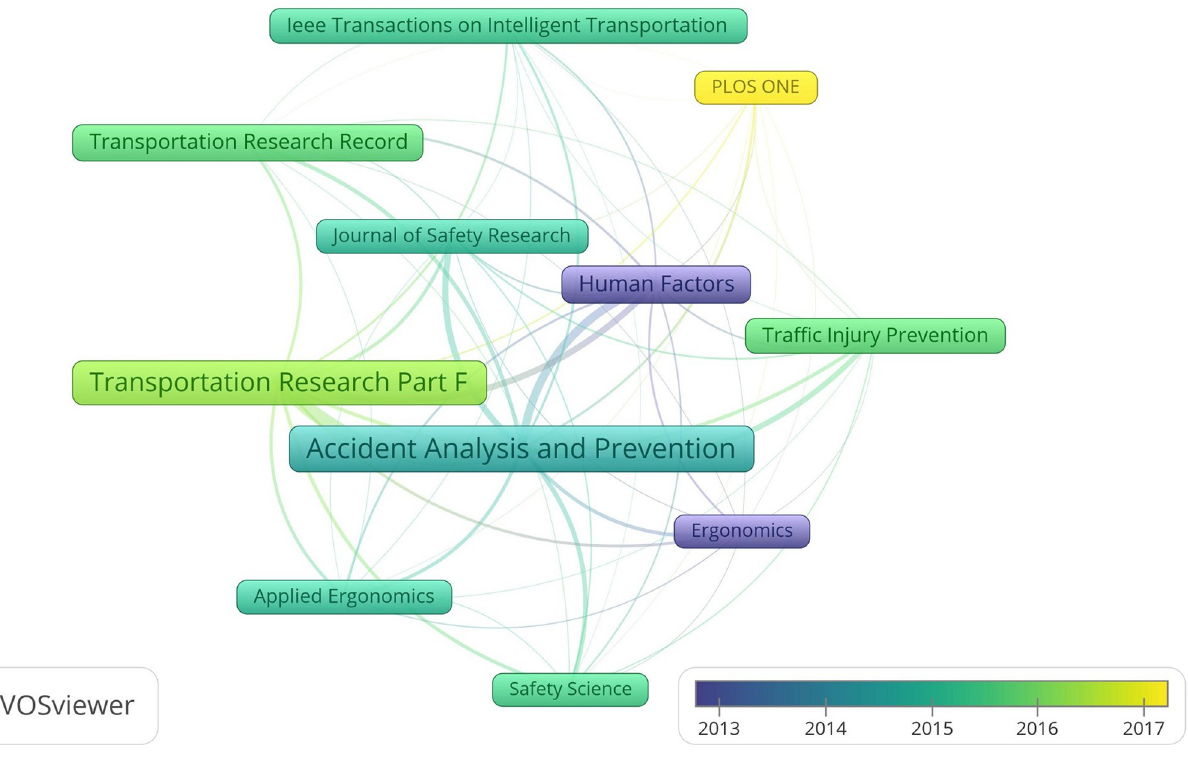
Fig 3. Major publication sources of